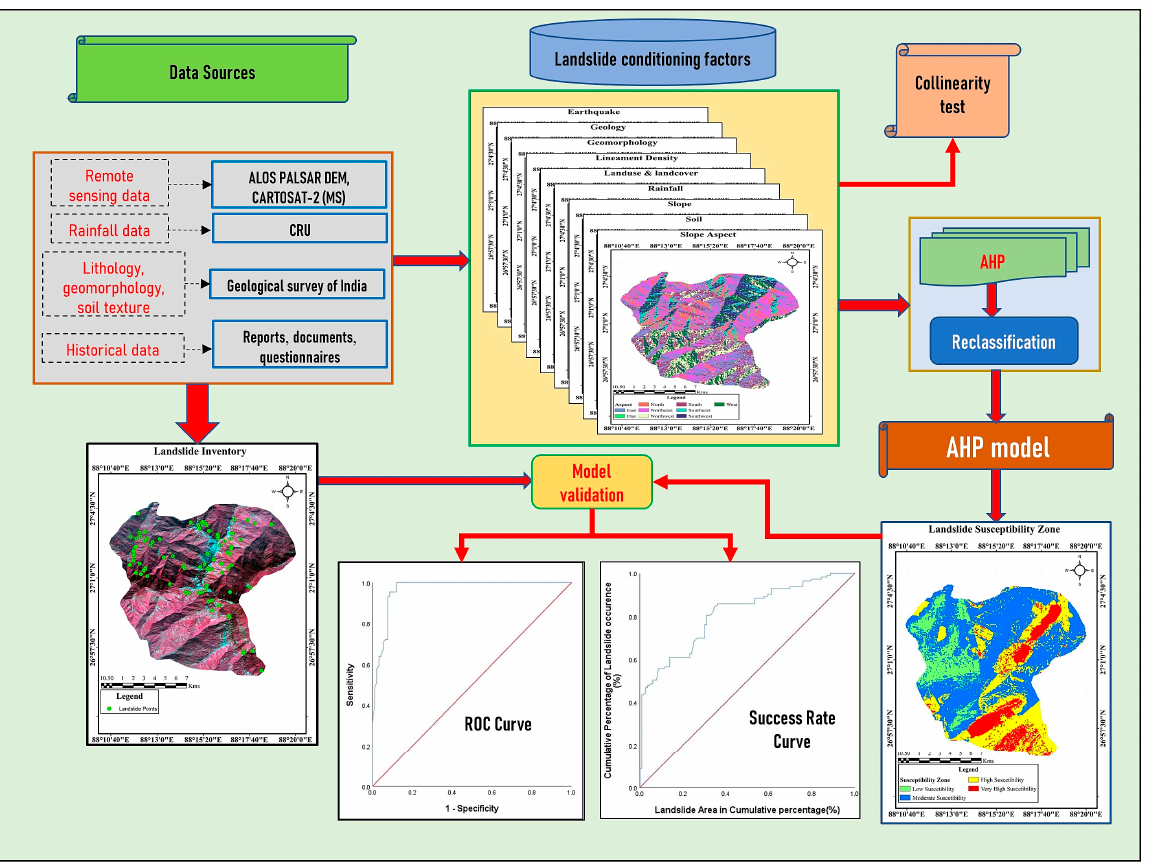
Figure 2. Graphical representation of overall methodology of landslide susceptibility